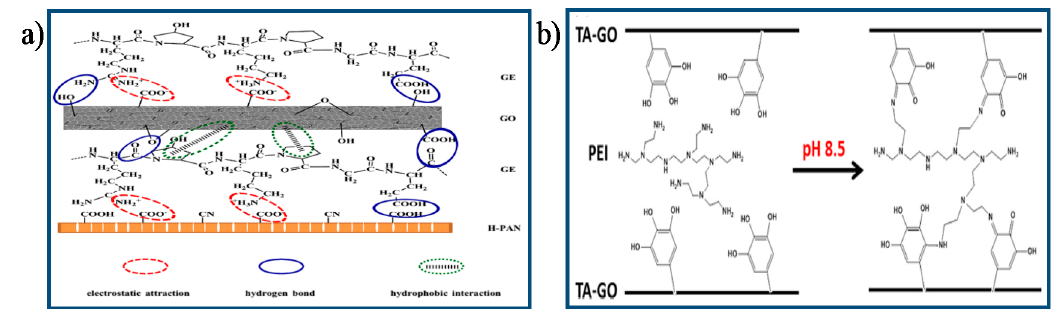
Figure 11. ( a ) Schematic illustration of the interfacial interaction in GO-based hybrid membrane [121] Copyright 2015 Elsevier; ( b ) schematic illustration of the formation of covalent bonding between adjacent TA–GO sheets [124]. Copyright 2016 Elsevier.